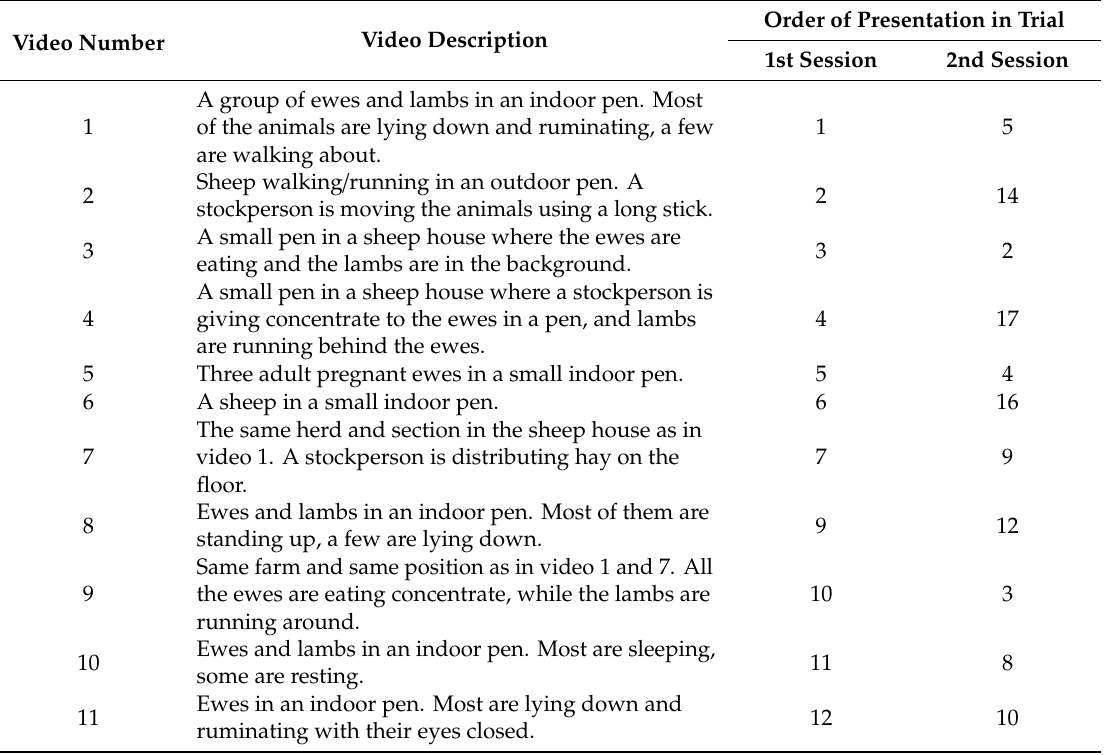
Table 2. Description of the videos used in this study. The order of presentation was di ff erent in the two scoring